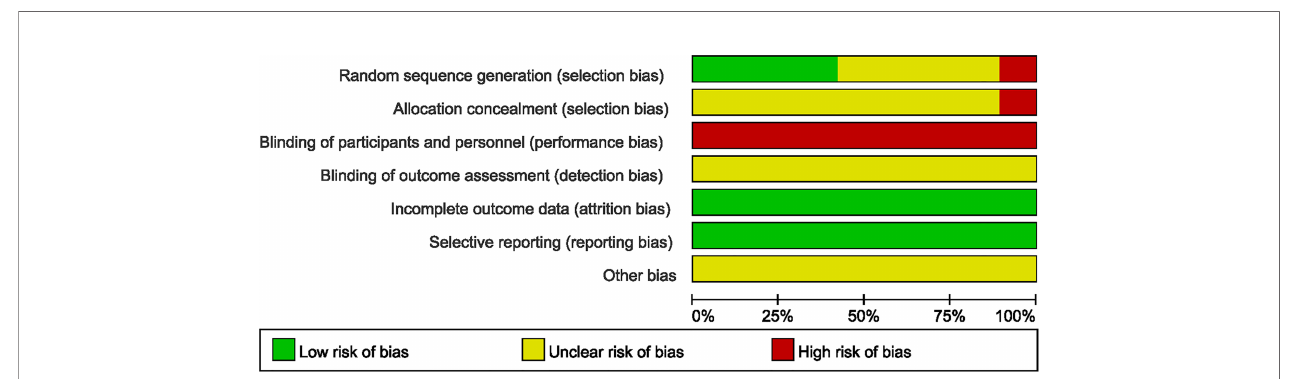
FIGURE 2 | Quality assessment of the included trials-Risk of bias